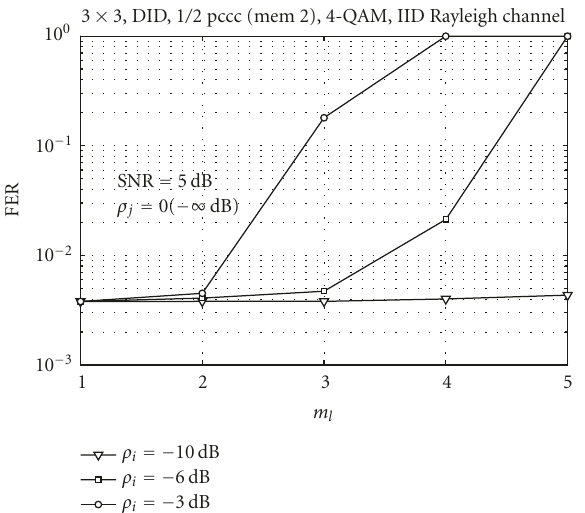
Figure 10: FER for SAIC-DID, plotted as function of the number of dominant cochannel signals m l at SNR = 5dB.